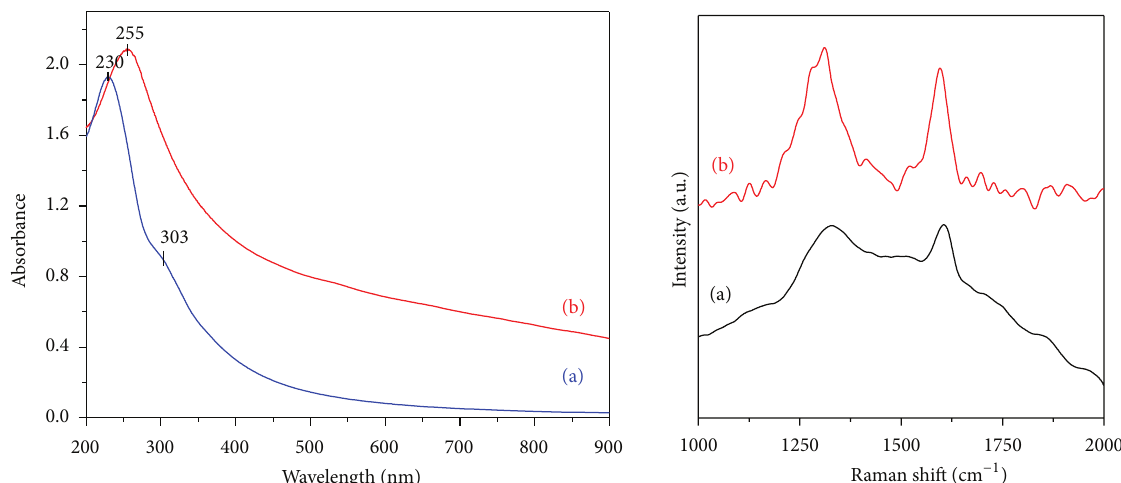
Figure 5: UV-Vis spectrum and FT-Raman spectra of (a) XGO and (b) RGO.